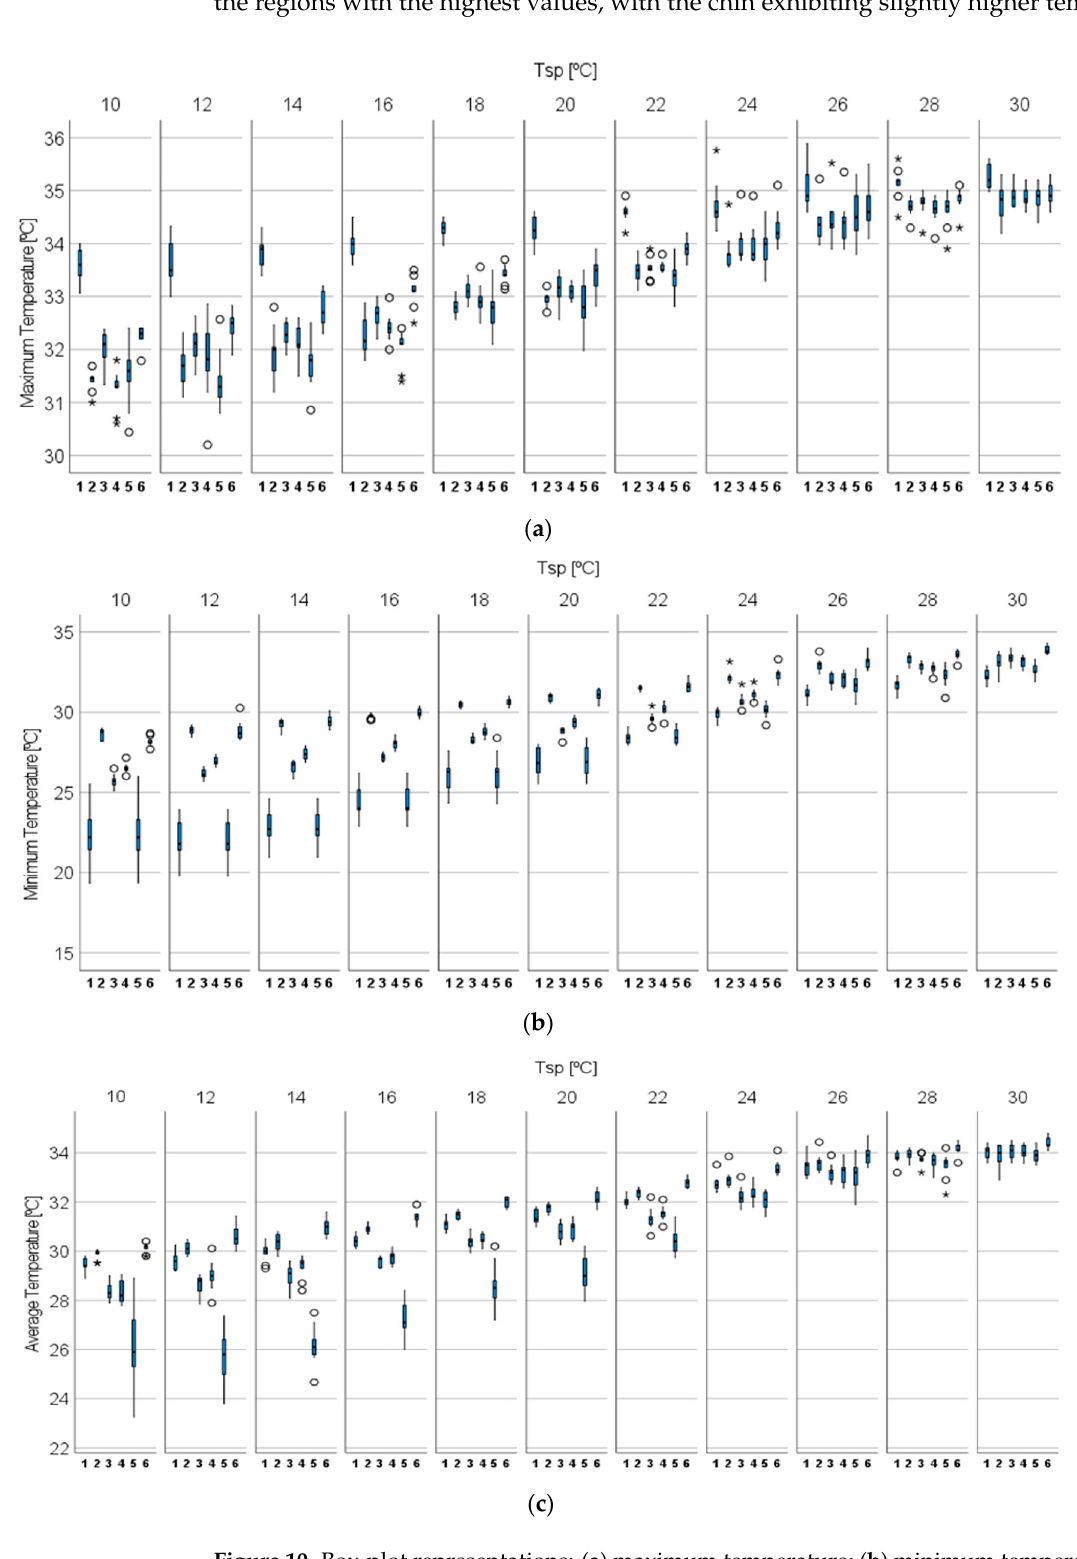
Figure 10. Box-plot representations: ( a ) maximum temperature; ( b ) minimum temperature; ( c ) average temperature for each region (1—face; 2—forehead; 3—cheekbone right; 4—cheekbone left; 5—nose; 6—chin).